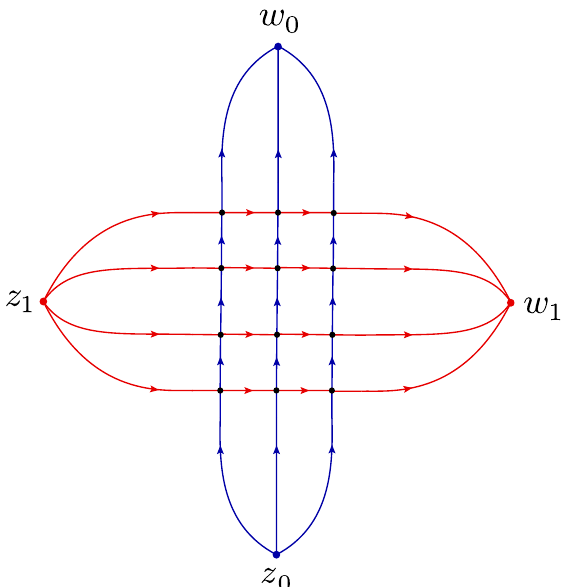
Figure 1 . Basso-Dixon type Feynman diagram for N = 4 ; L = 3. The propagators have the form [ w z ] (cid:0) (cid:11) where (cid:11) = 1 = 2 ! for vertical and horizontal lines, respectively. (cid:0) (cid:6)